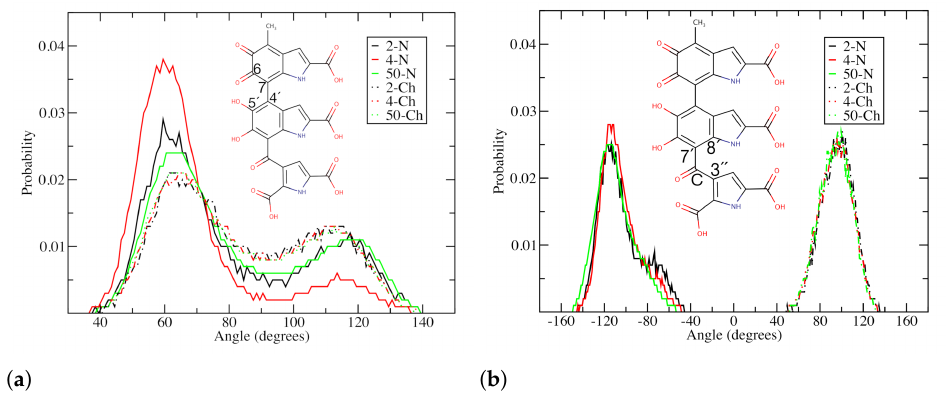
Figure 8. Dihedral angle distributions for all the systems over the last 100ns: ( a ) C6-C7-C4 (cid:48) -C5 (cid:48) atoms and ( b ) C8 (cid:48) -C7 (cid:48) -C-C3 (cid:48)(cid:48) atoms. Solid lines: uncharged molecules. Dotted lines: charged molecules.